Question: According to the figure, is the described quantity increasing or decreasing?
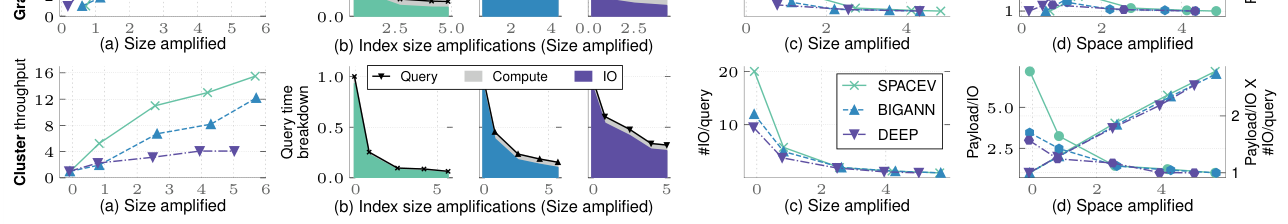
Answer: increasing